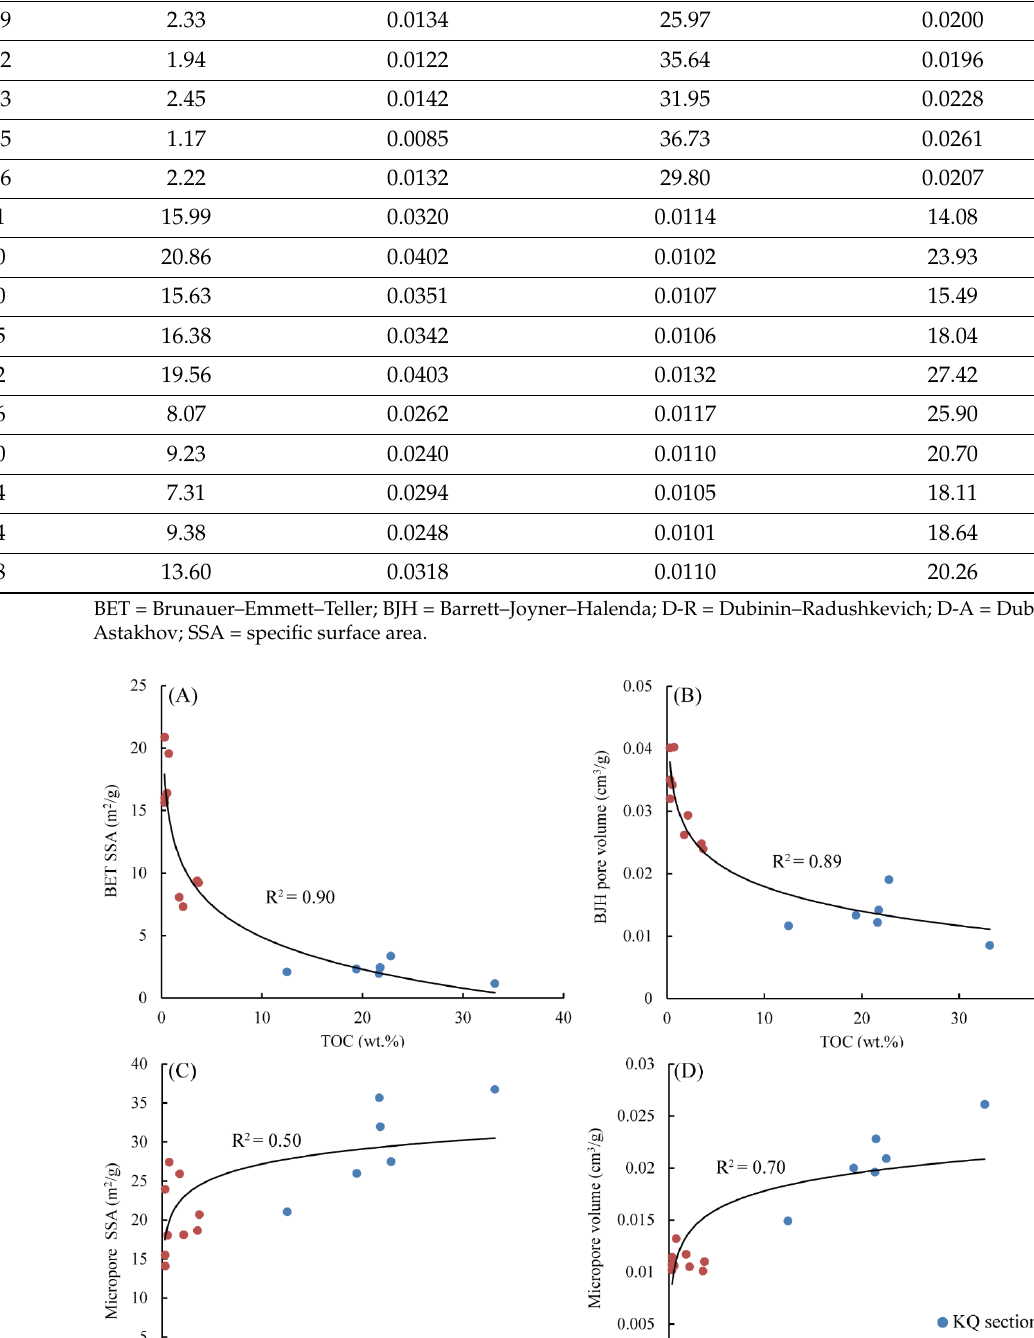
Figure 5. Relationships between ( A ) BET SSA; ( B ) BJH pore volume; ( C ) D-R micropore surface area; and ( D ) D-A micropore volume and total organic carbon (TOC) content.